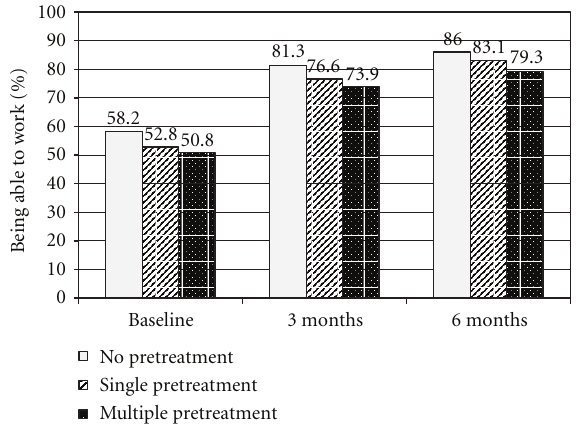
Figure 4: Subgroup analysis by type of pretreatment for % patients being able to work at baseline, 3 months and 6